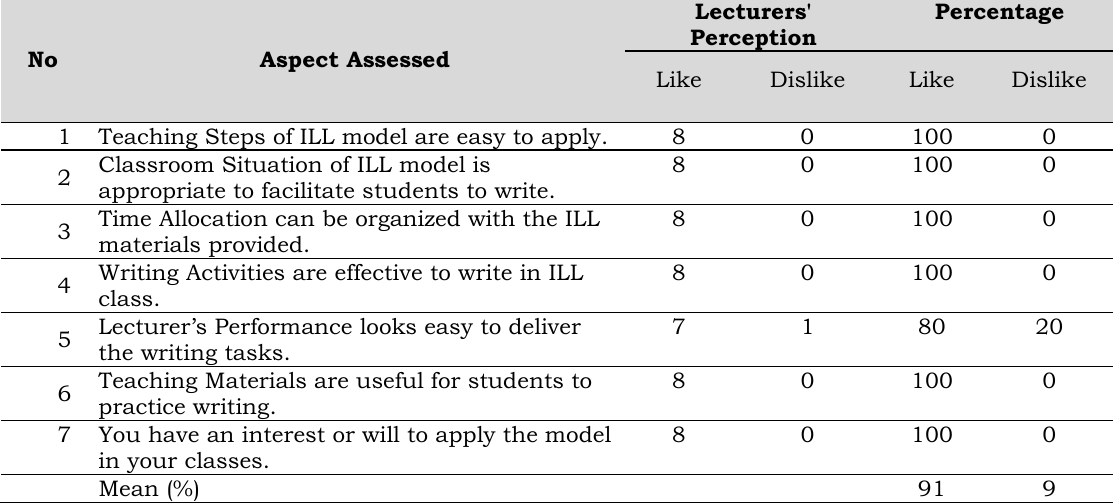
Table 4. The result of questionnaire on lecturer’s